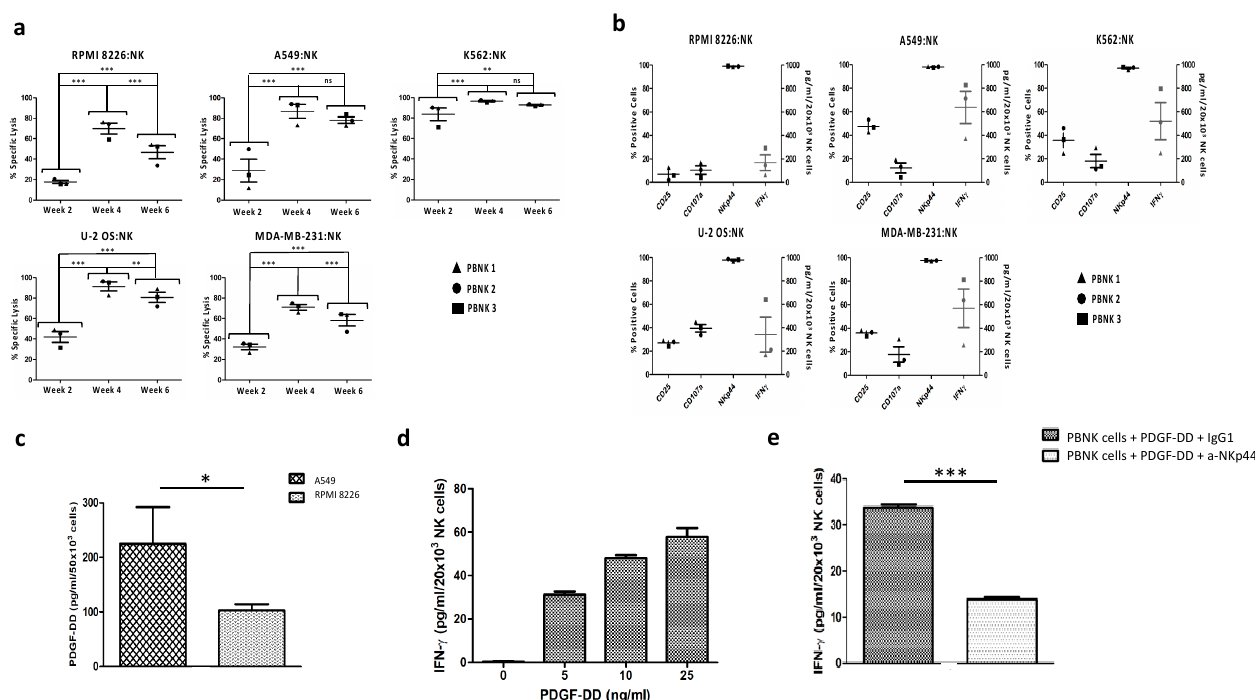
Figure 2. Cytotoxicity of expanded PBNK cells and expression of cytotoxicity-associated molecules. ( a ) The cytotoxicity of three expanded PBNK cell donors towards RPMI 8226, A549, K562, U-2 OS, and MDA-MB-231 measured using the bioluminescence imaging assay at a 1:1 effector-to-target ratio for 24 h. ( b ) Expression of cytotoxicity-associated molecules (CD25, CD107a, NKp44, and IFN- γ ) in PBNK cells in the fourth week of expansion after coculture with the different cancer cell lines (RPMI 8226, A549, K562, U-2 OS, and MDA-MB-231) at a 1:1 effector-to-target ratio for 24 h. ( c ) Expression of PDGF-DD in A549 and RPMI 8226. ( d ) Histogram with IFN- γ expression by PBNK cells after stimulation with different concentrations of PDGF-DD. ( e ) Graphic with IFN- γ expression by PBNK cells after stimulation with 5 ng/mL of PDGF-DD and IgG1, and after stimulation with 5 ng/mL of PDGF-DD and the anti-NKp44 mAb. Data in ( a , b ) are means ± SEM of the three expanded PBNK cell donors. Data in ( c – e ) are presented as means ± SD from three technical replicates of a PBNK cell pool. ns, not significant, *, p < 0.05, **, p < 0.01, ***, p < 0.001, one-way ANOVA, repeated measures test and Student’s t -test.